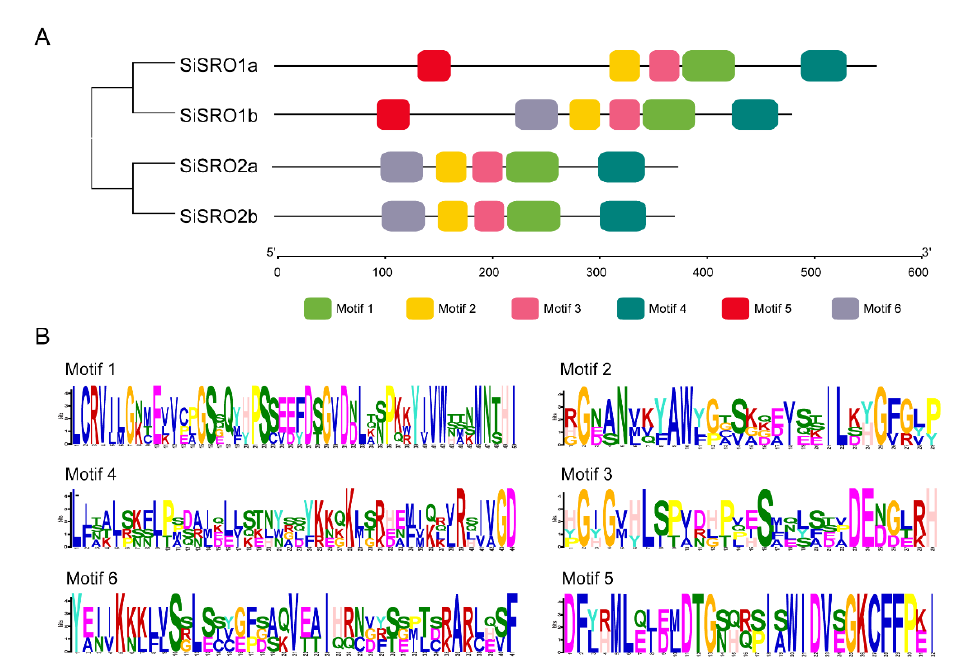
Figure 2. The exon-intron structure and conserved domain organization of SRO family in sesame. ( A ) Exon-intron structures of SiSRO genes. Exons and introns are shown as green rounded rectan- gles and black lines, respectively. ( B ) Schematic representation of conserved domains of SiSROs.